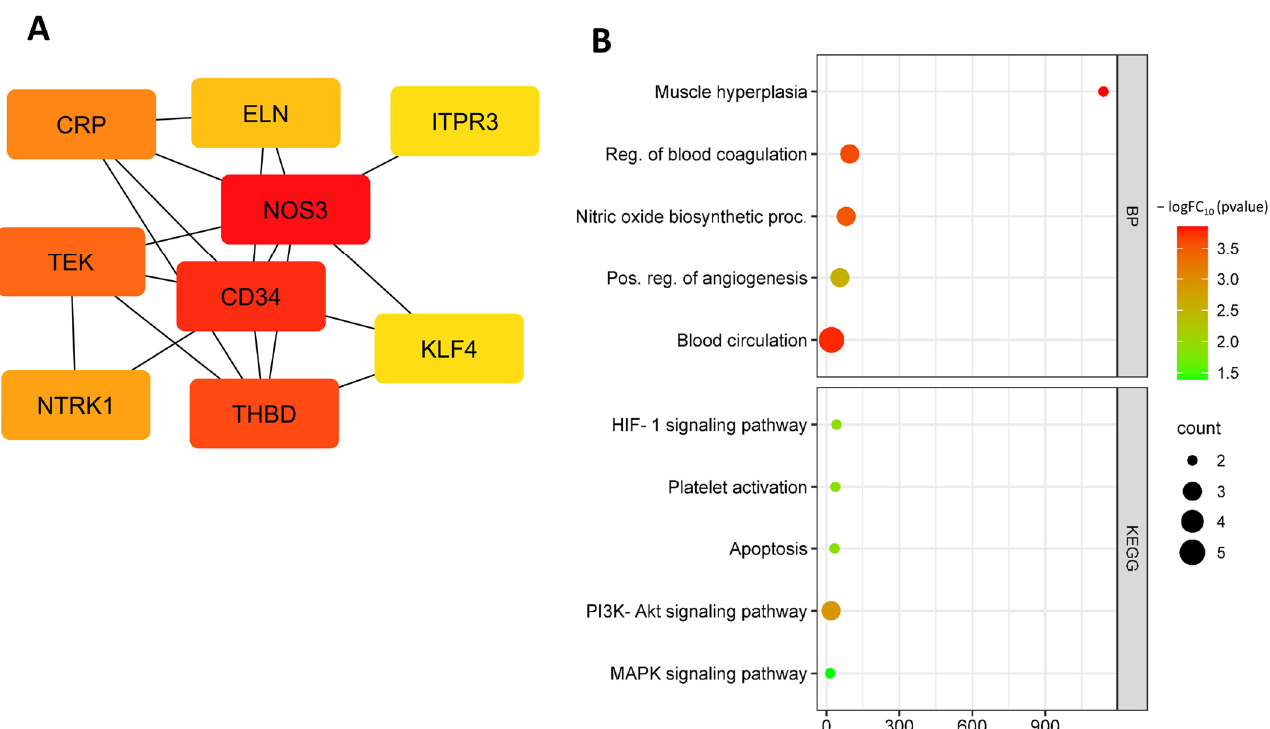
Figure 3. Down-regulated hub DEGs at OS ( A ) and functional enrichment of down-regulated hub DEGs at OS ( B ). Table 1. Functional roles and general information of the down-regulated hub genes.